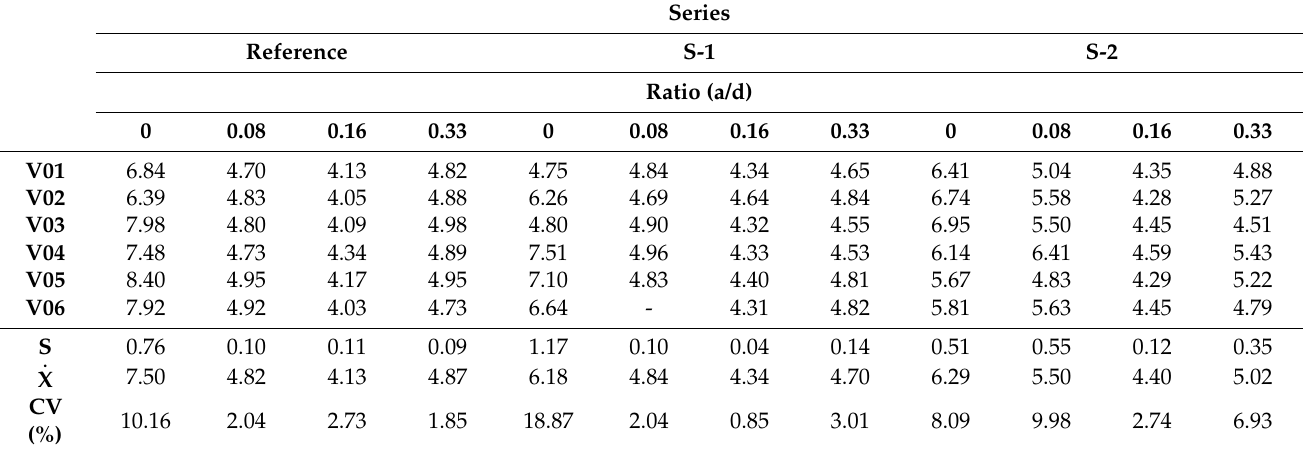
Table 3. Computed stresses at the proportional limit (N/mm 2 ).